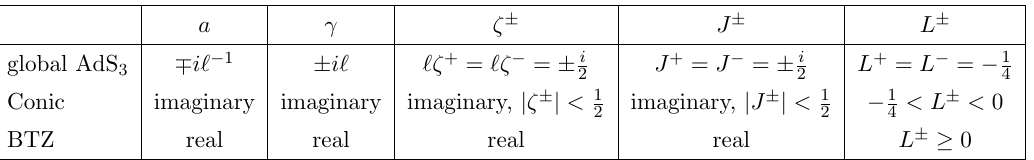
Table 1 : Conditions on free functions for zero mode solutions in various formulations; note our normalization J (cid:6) = J (cid:6) =k as compared to the entropy formula (1.3). upon a cumbersome coordinate transformation. The result is relating the functions L (cid:6) and J (cid:6) through a twisted Sugawara construction [14, 17, 53]